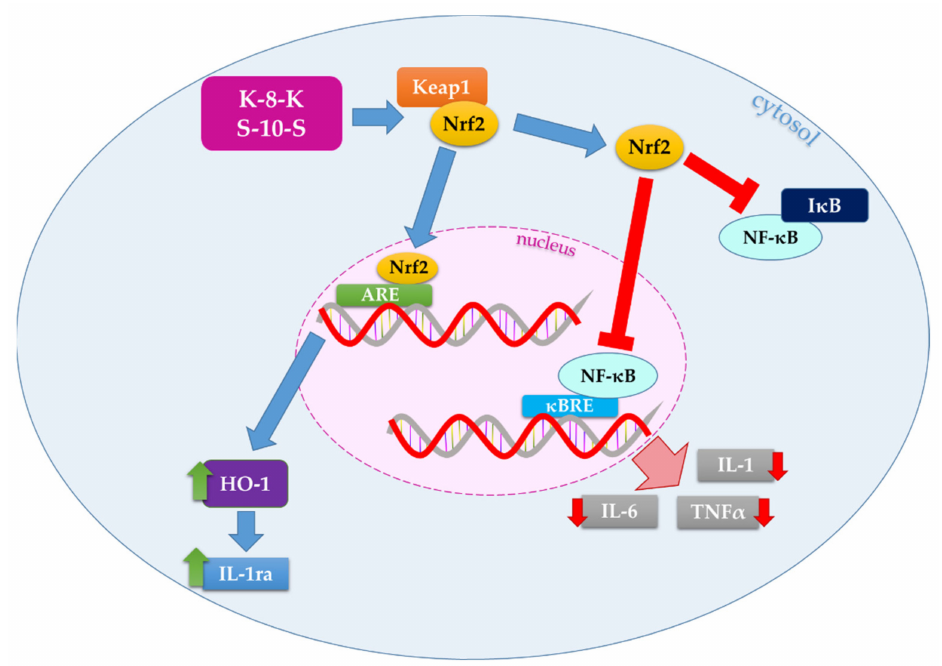
Figure 7. Schematic representation of the molecular mechanism of the antioxidant bioactive pep- tides, exerting anti-inflammatory effects by inhibiting the NF- κ B pathway. Keap1: Kelch-like ECH- associated protein 1; Nrf2: nuclear factor erythroid 2-related factor 2; NF- κ B: nuclear factor kappa- light-chain-enhancer of activated B cells; I κ B: inhibitor of nuclear factor kappa B; ARE: antioxidant response element; κ BRE: κ B response element; HO-1: heme